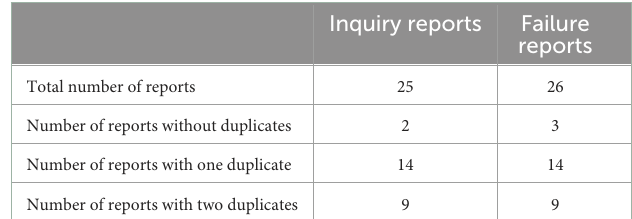
TABLE 2 Dataset used in the